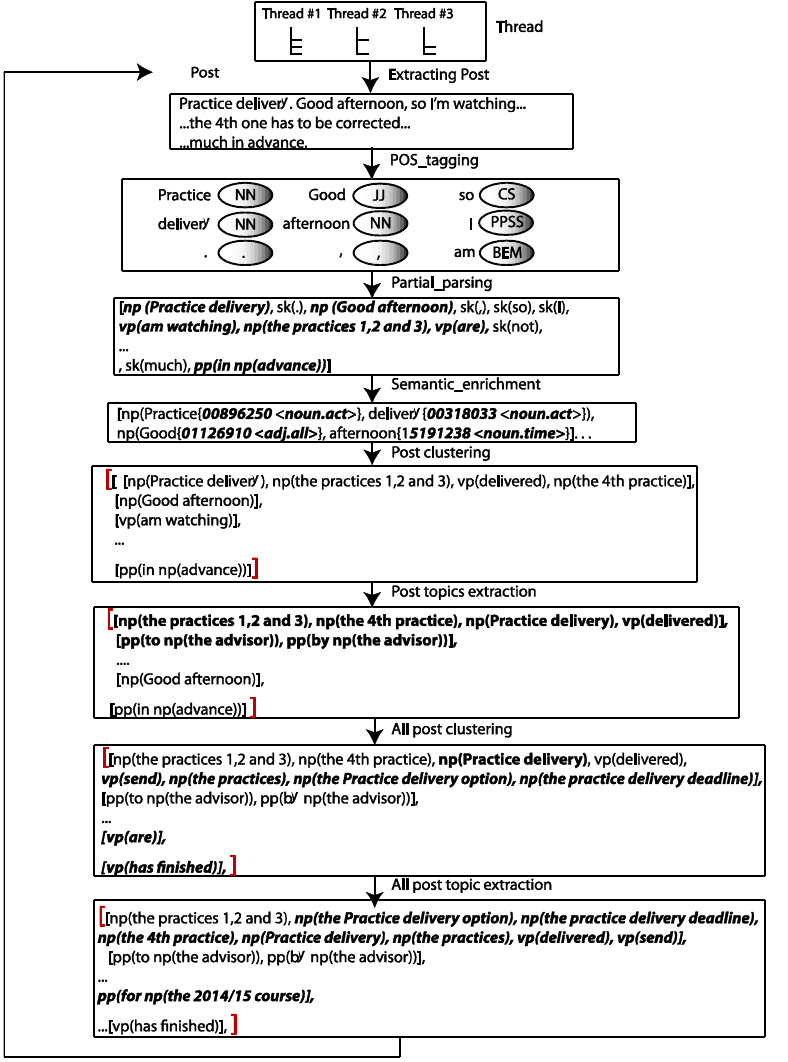
Figure 4. General process of the